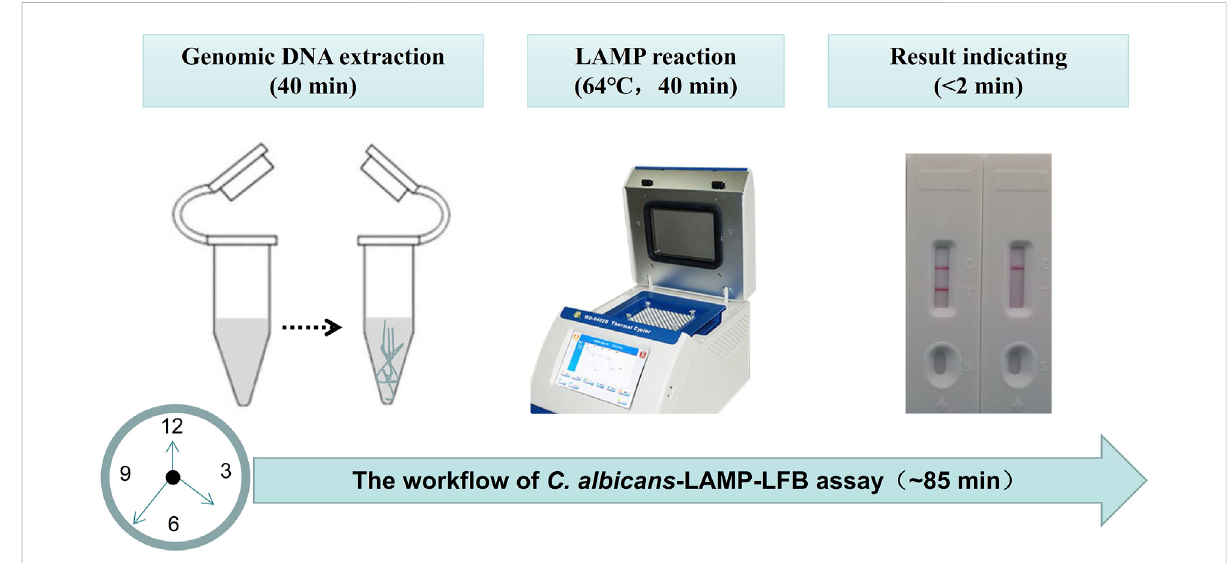
FIGURE 6 The work fl ow of C. albicans -LAMP-LFB assay. Three steps, including Genomic DNA extraction (40 min), LAMP reaction (40 min) and result reporting ( < 2 min), are required for the C. albicans -LAMP-LFB assay, and the total procedure can be completed within 85